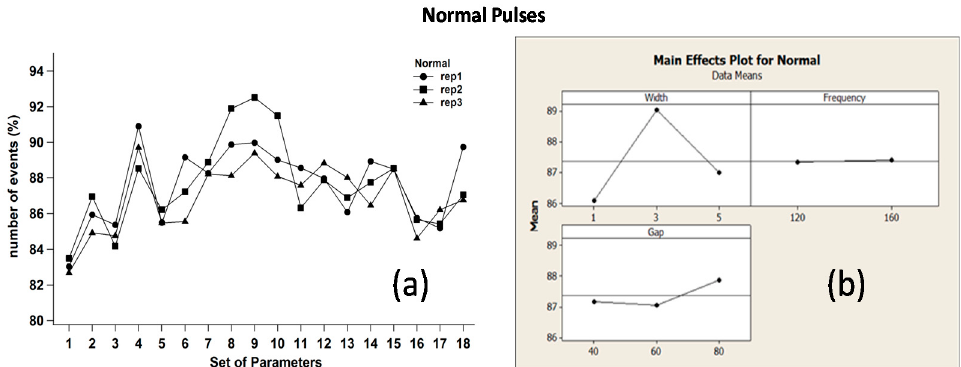
Figure 7. ( a ) Replica diagrams and ( b ) main effects plot related to normal pulses.